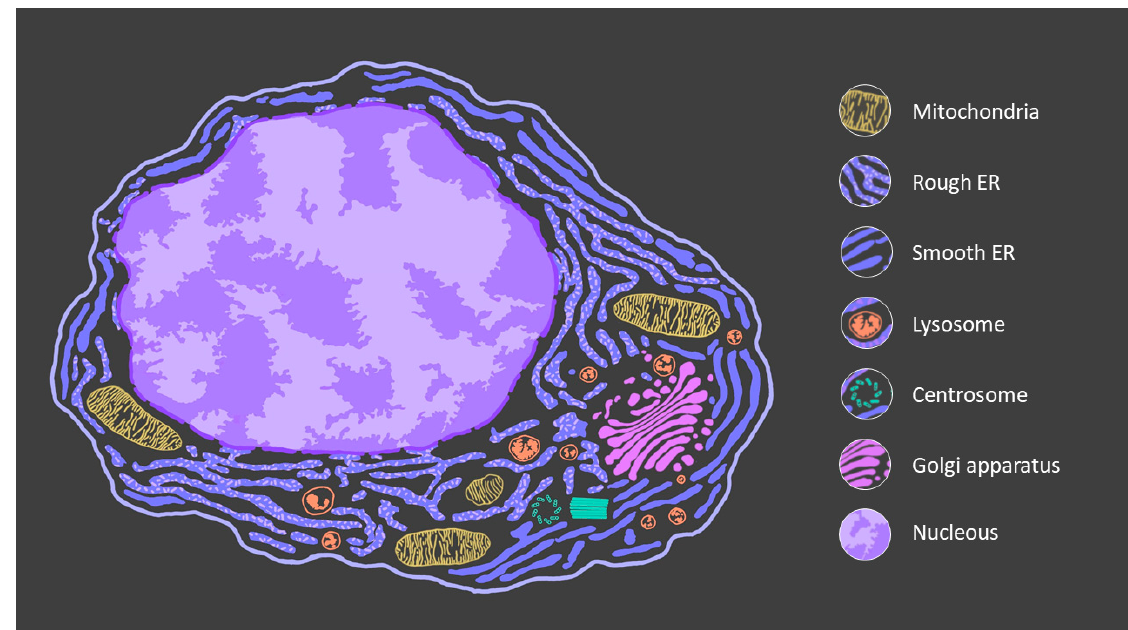
Figure 2. Gross architecture of a eukaryotic cell.